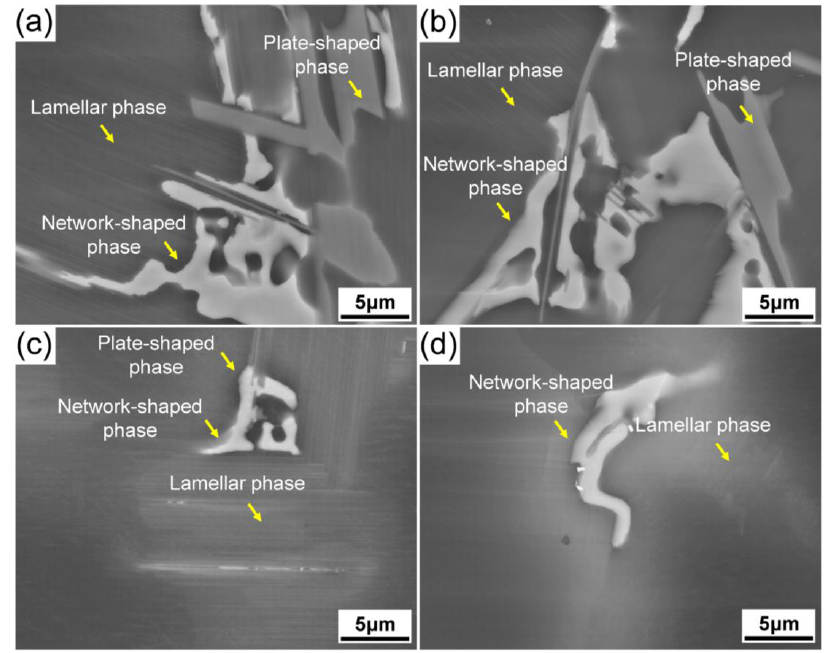
Figure 6. SEM micrographs of the secondary phases in the as-cast alloys: ( a – c ) 0.5Zn-xAl (x = 0.2, 0.5, and 1.0); ( d ) 0Zn-1.0Al.